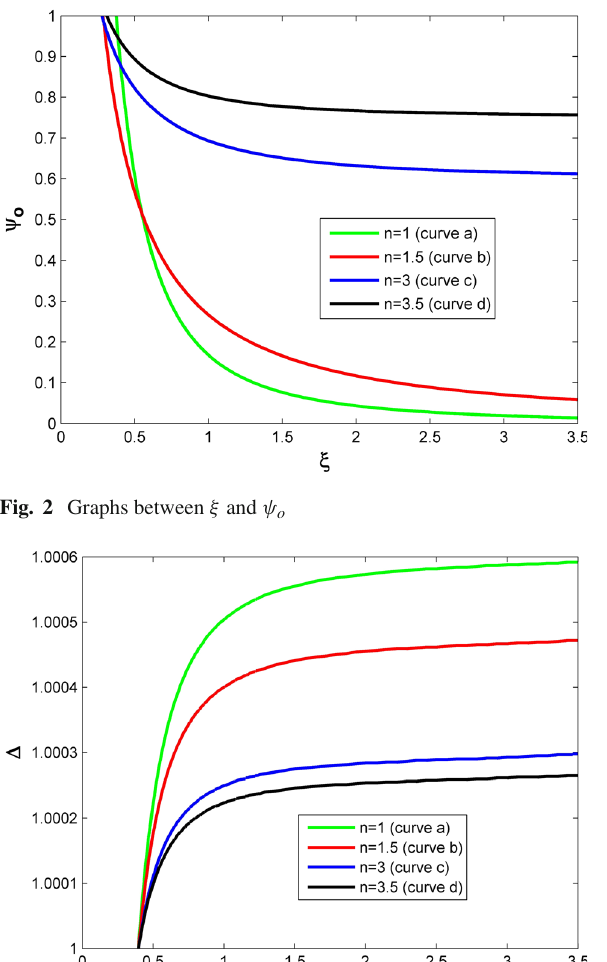
Fig. 1 Graphs between ξ and v